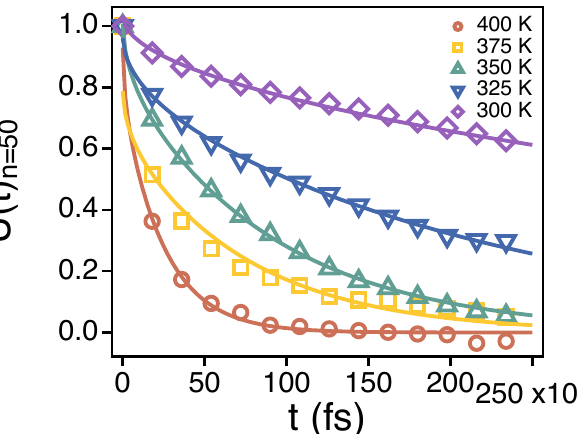
Figure 6. The end-to-end vector time correlation function U ( t ) of the whole chain ( n = 50) at different temperatures. The solid lines are fits to Equation (4) for the observed temperatures. The statistical errors are smaller than the